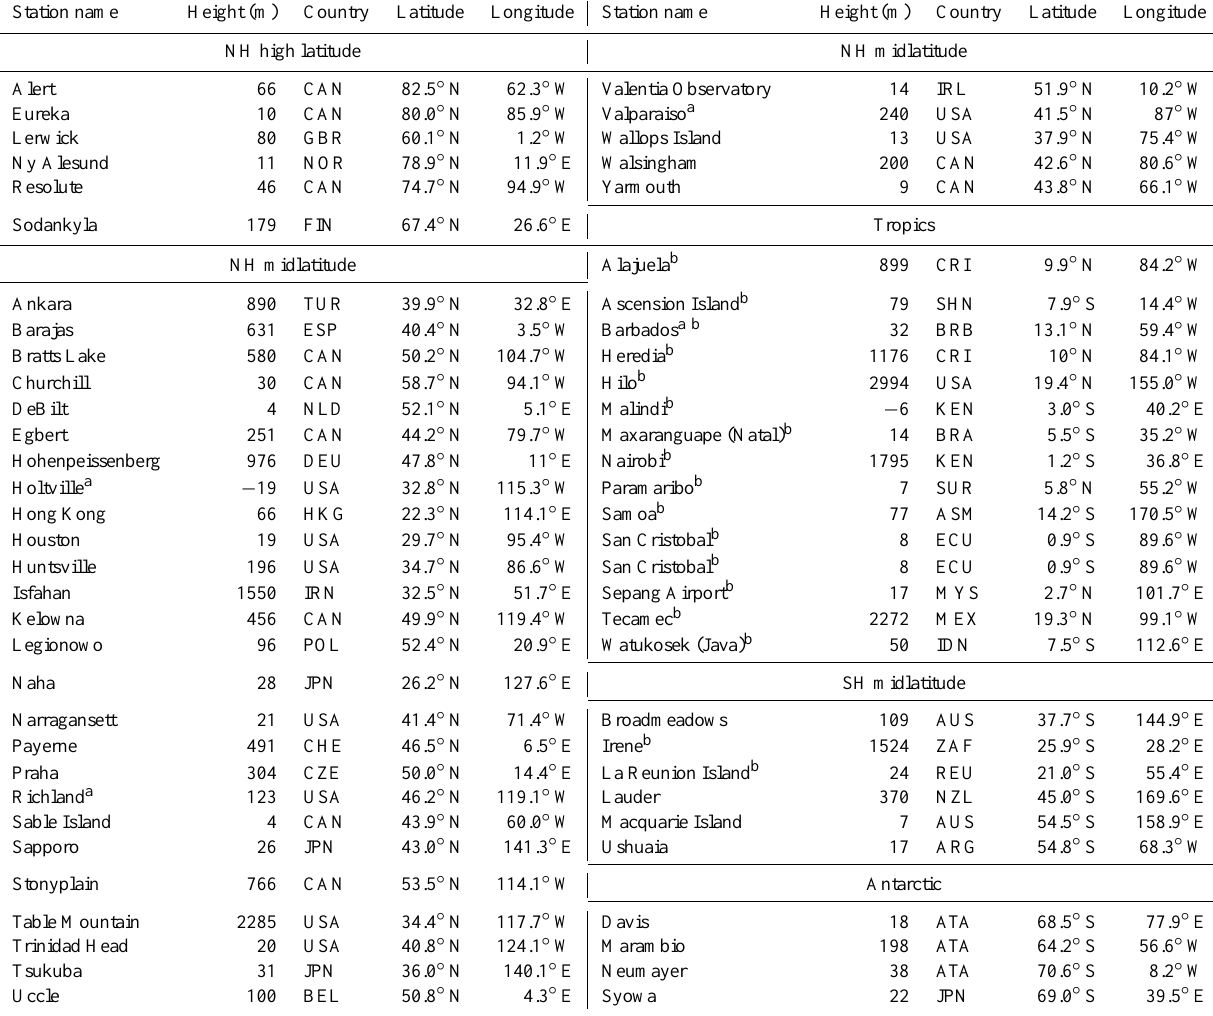
Table 1. WOUDC and SHADOZ stations used in the